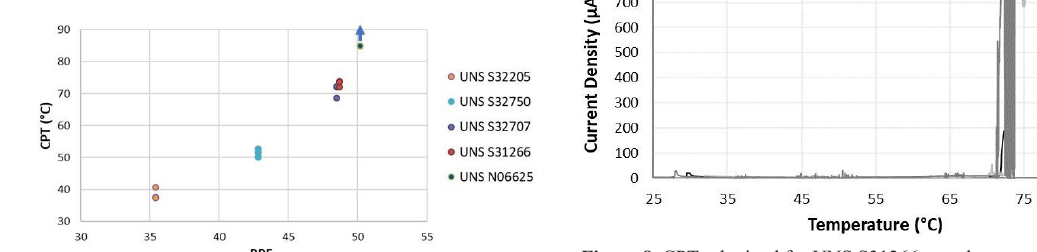
Figure 3. Cross section micrograph of the UNS N10276 sample after etching.